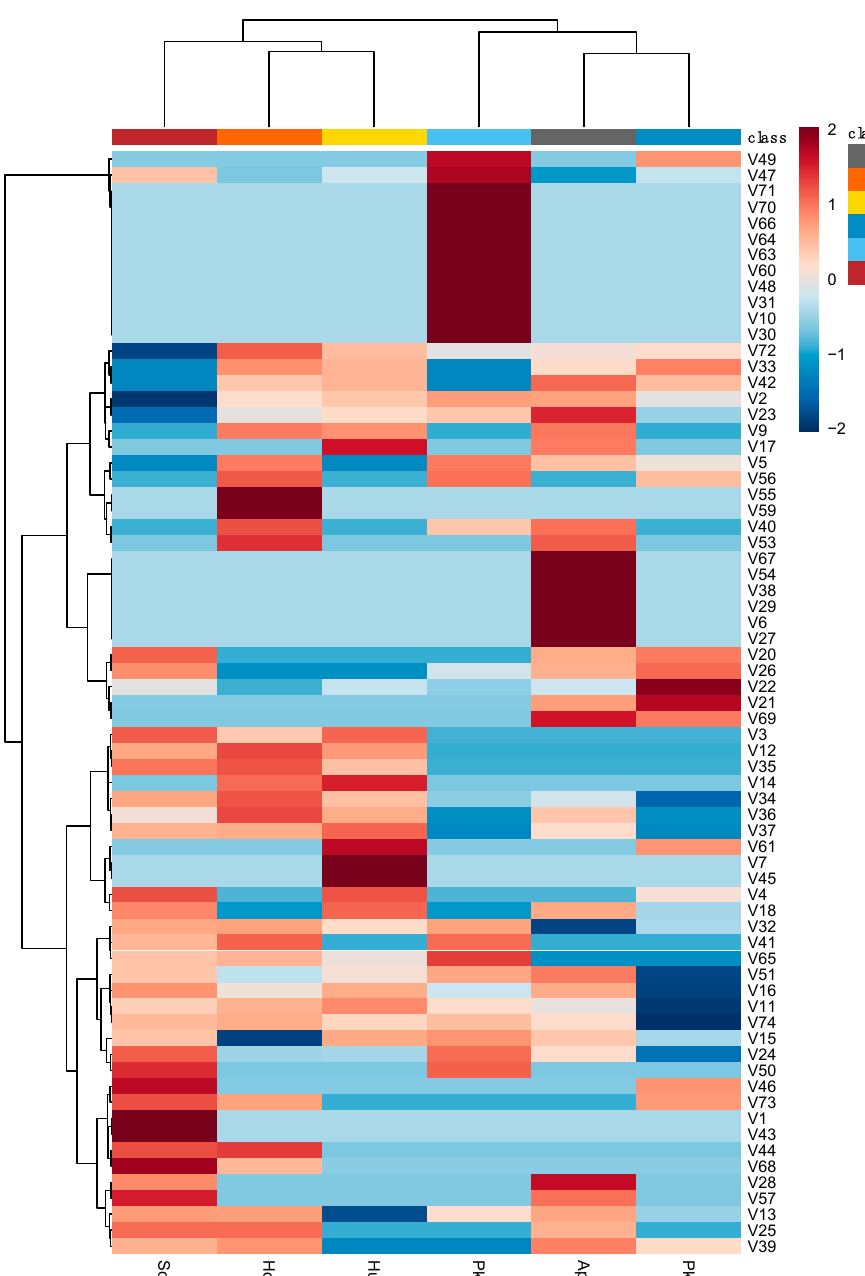
Figure 8. Clustered heatmap based on the volatile compounds in inoculated fermentations with candidate yeast strains compared to S. cerevisiae BY4742. Data were normalized by a pooled sample from the control group, S. cerevisiae BY4742. The correlation between each compound and candidate strain is illustrated with a chromatic scale (from dark blue, negative correlation, to dark red, positive correlation). Dendrogram for the hierarchical clustering was analyzed using Ward’s cluster algorithm. Abbreviations: Ap, A. pullulans (class 1, black); Ho, H. opuntiae (class 2, orange); Hu, H. uvarum (class 3, yellow); Pk, P. kluyveri (class 4, dark blue); Pki, P. kudriavzevii (class 5, blue); Sc, S. cerevisiae (class 6, red).